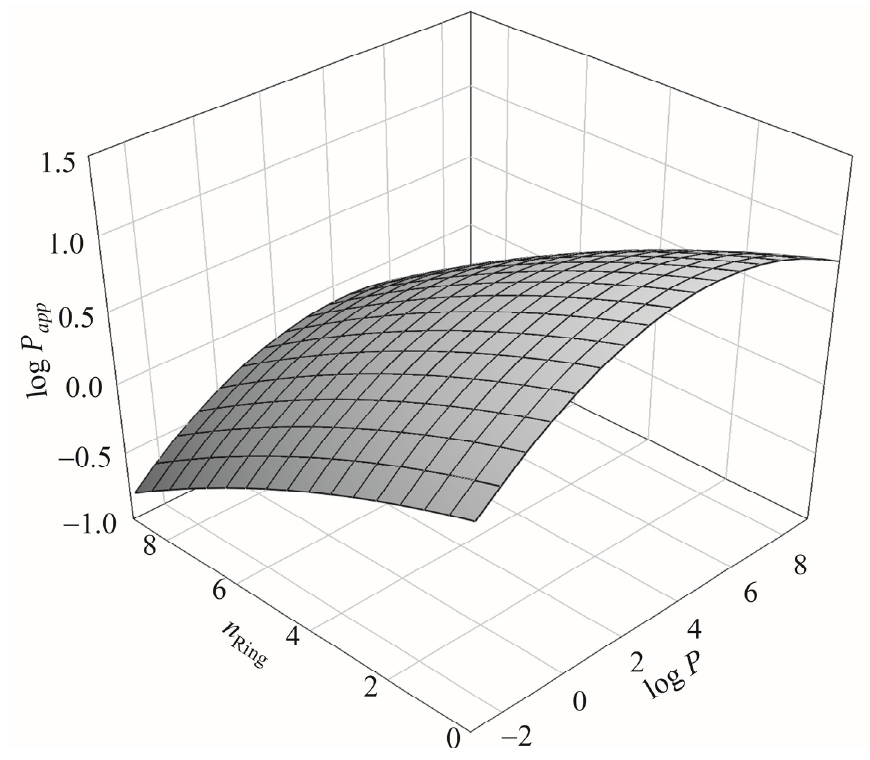
Figure 10. The relationship among log P app , n Ring , and log P in 3D presentation.